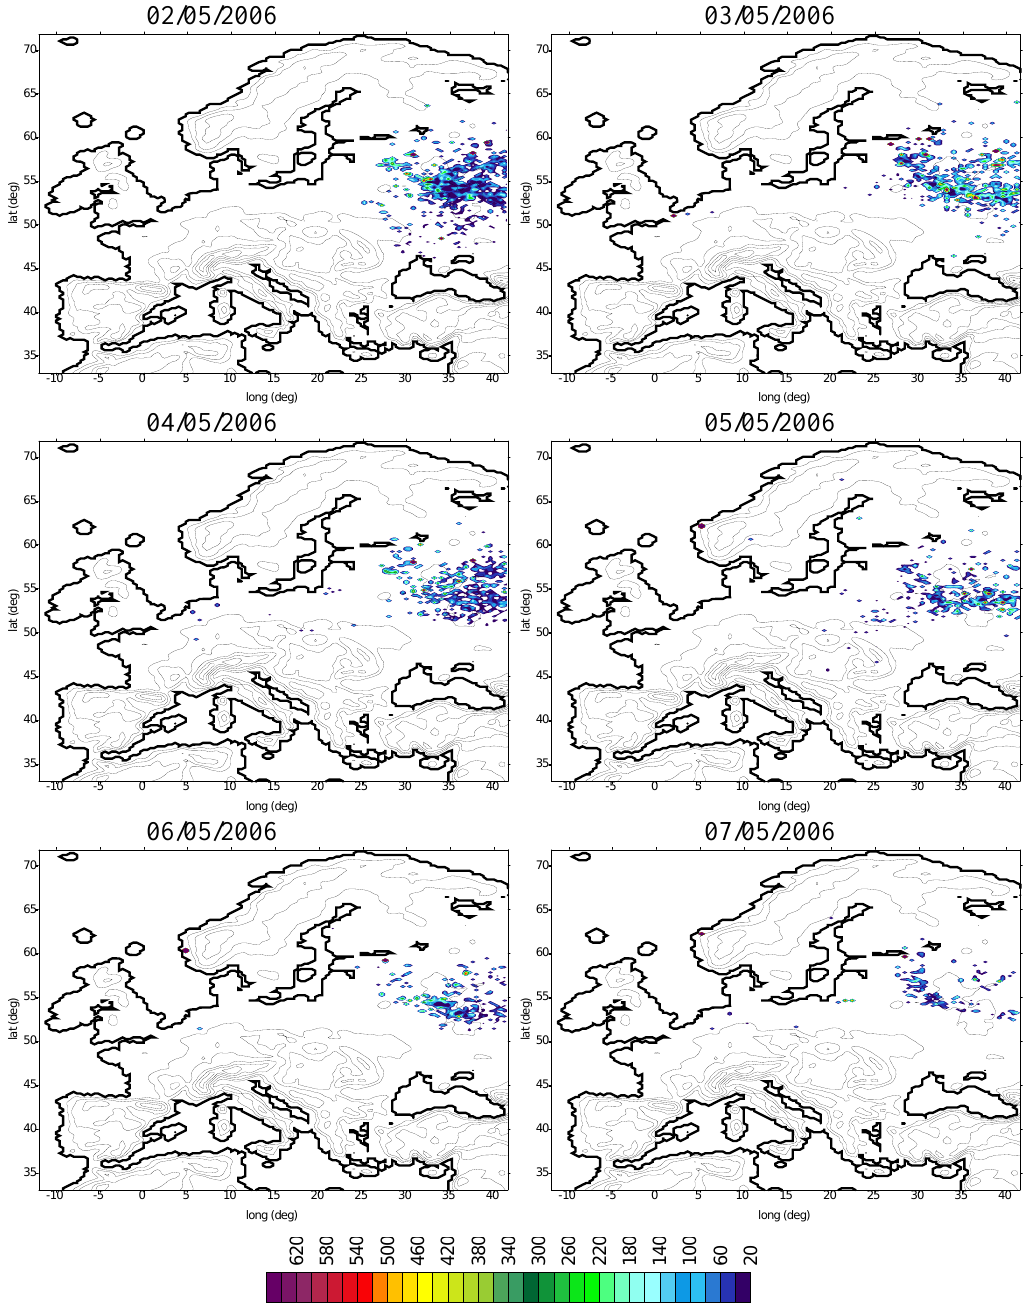
Fig. 3. Daily patterns of NO x emissions (t), originated from fires (grass), during the period 2–7 May 2006.